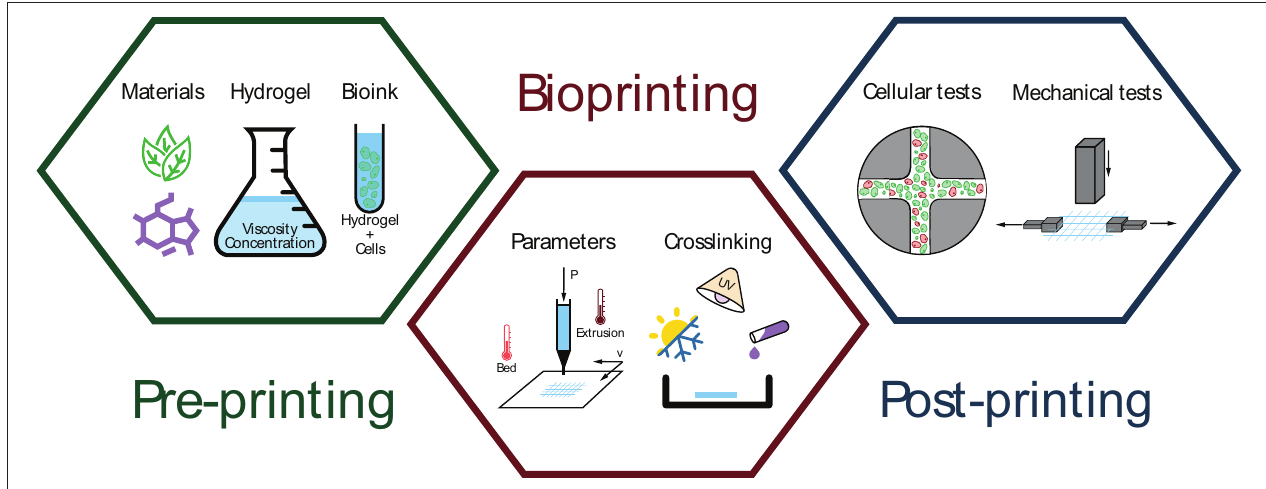
FIGURE 1 | Schematic representation of three bioprinting stages: pre-printing (material selection, hydrogel synthesis, and bioink generation), extrusion-based bioprinting (parameters and cross-linking methods), and post-printing analysis (cellular and mechanical